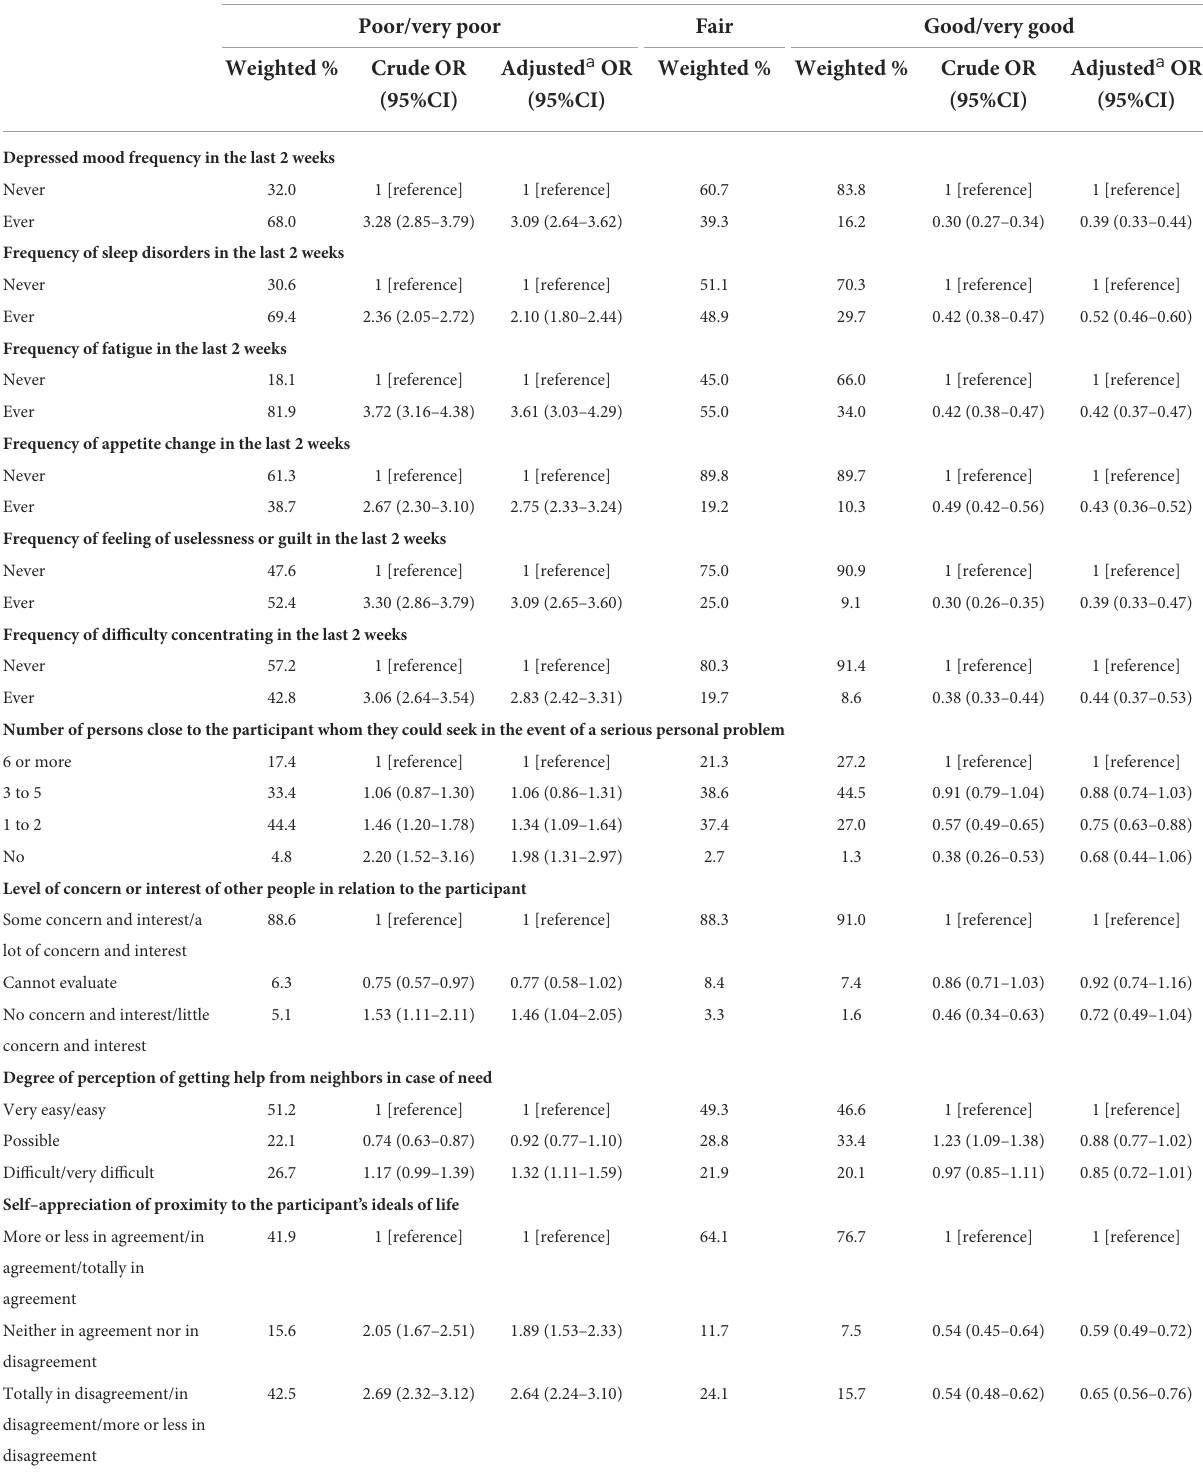
TABLE 6 Association between mental health, social support and satisfaction with life, and self-perceived health status. Self-perceived health status Poor/very poor Fair Good/very good Weighted % Crude OR Adjusted a OR Weighted % Weighted % Crude OR Adjusted a OR (95%CI)